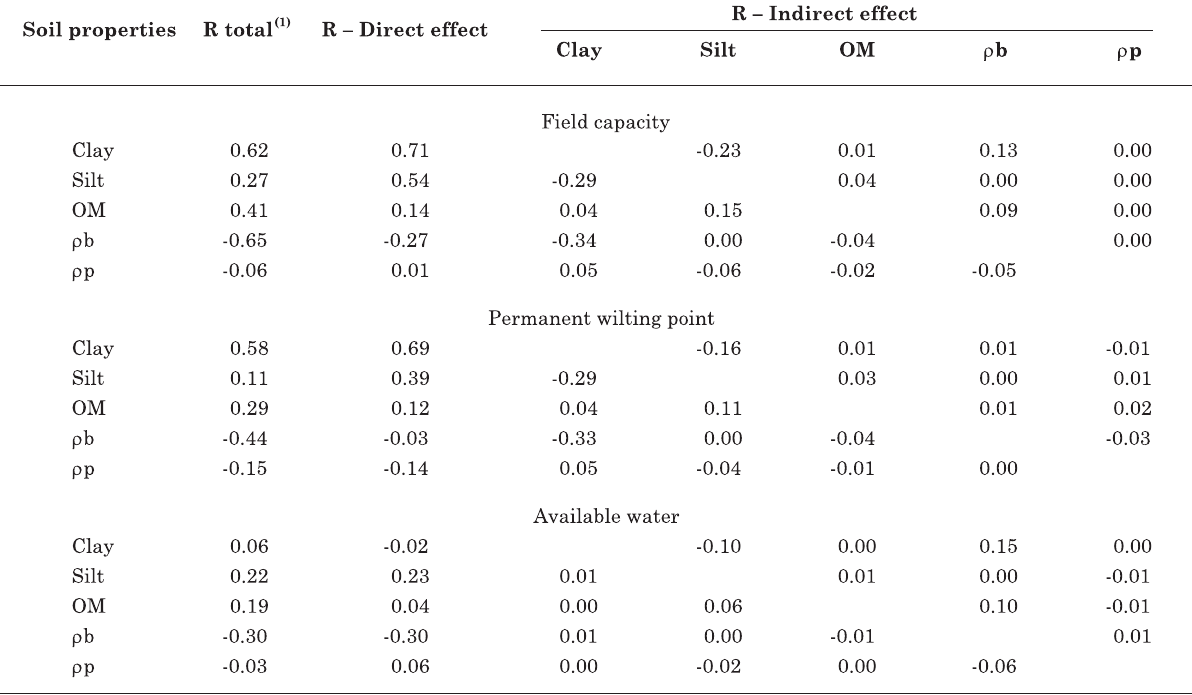
Table 6. Correlation coefficients considering the direct and indirect effects obtained by path analysis between the contents of clay, silt, organic matter (OM), bulk density ( ρρρρρ b) and particle density ( ρρρρρ p), with the gravimetric soil water content retained at field capacity (10 kPa), at the permanent wilting